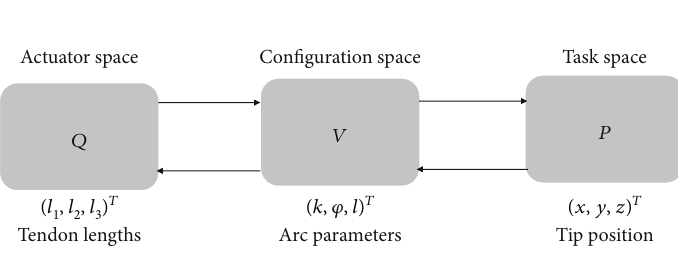
Figure 2: Mapping between joint space variables, con fi guration space variables, and workspace variables.